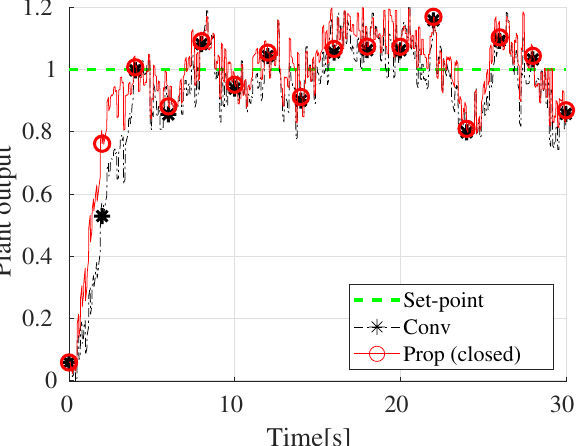
Figure 11. Output trajectories of unstable plant in the presence of noise.